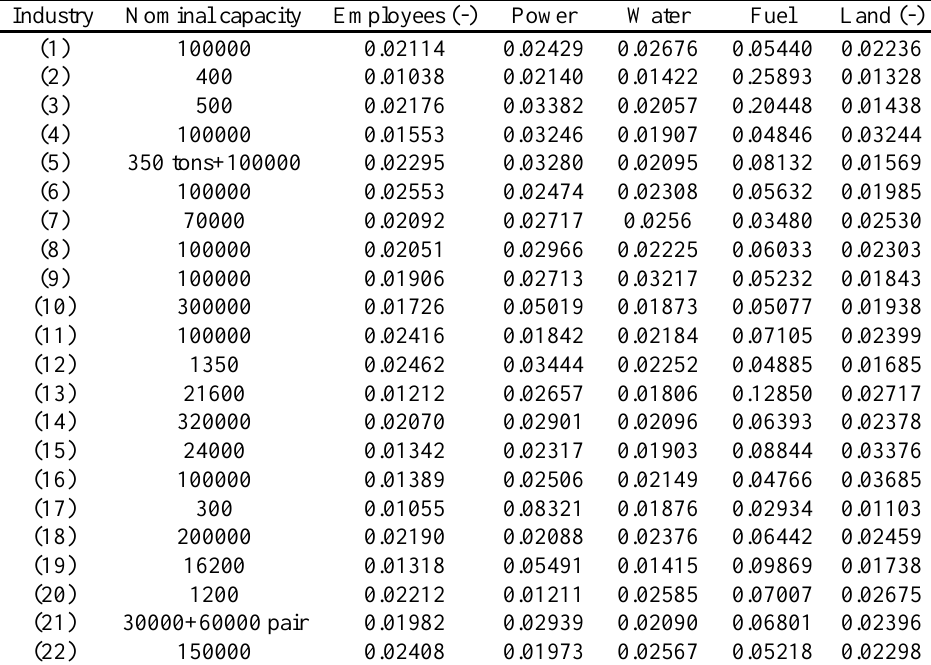
Table 4. The normalized and weighted decision